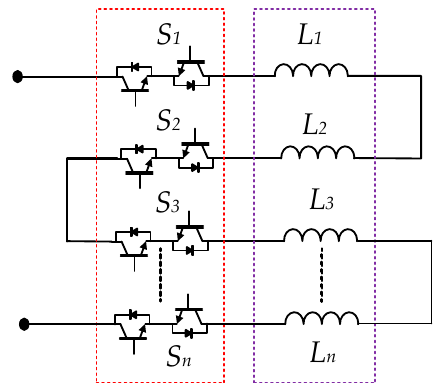
Figure 1. Proposed FCLC for DCCB used in auxiliary branch of breaker. Figure 1 . Proposed FCLC for DCCB used in auxiliary branch of breaker. Figure 1 . Proposed FCLC for DCCB used in auxiliary branch of breaker.